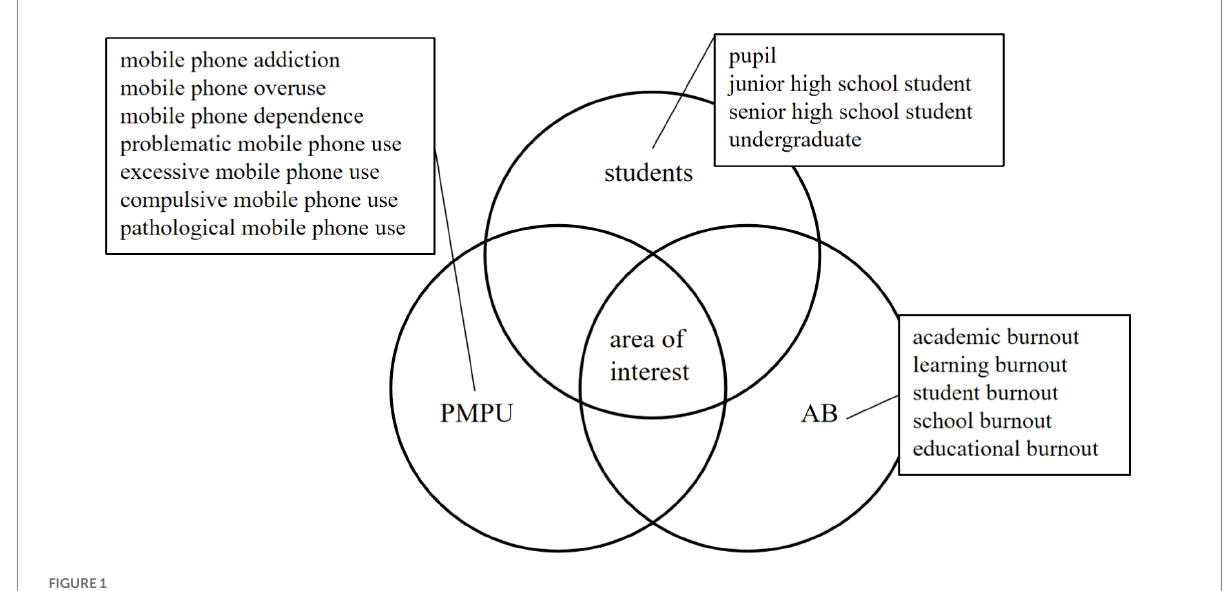
FIGURE 1 Diagram of search term